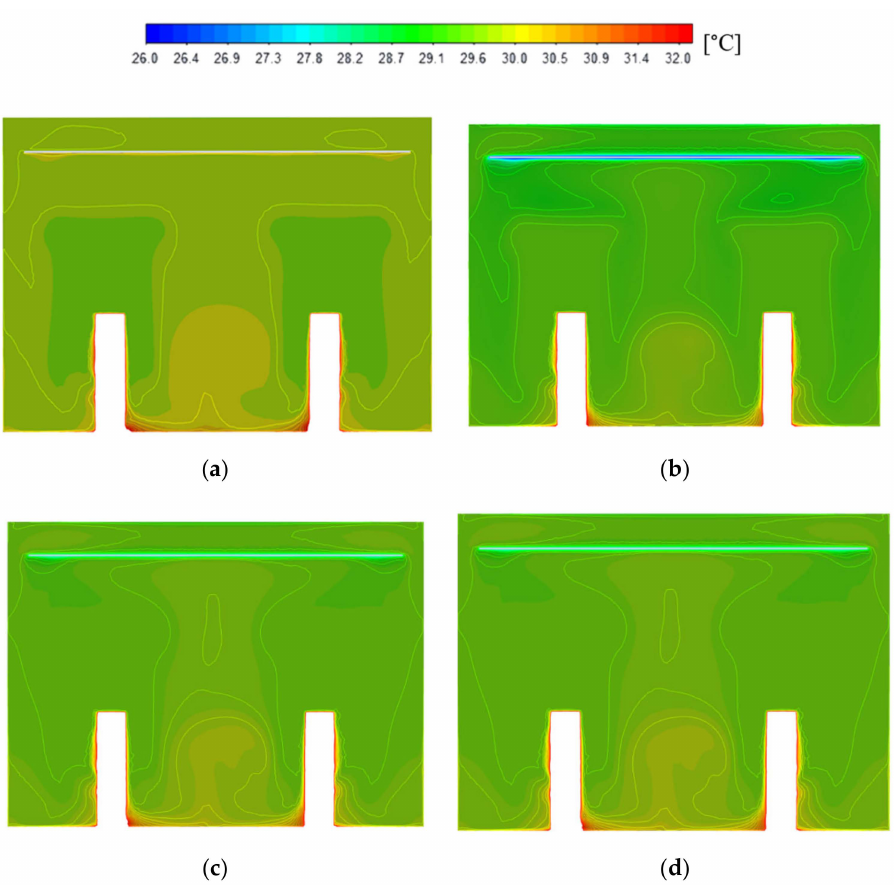
Figure 3. Temperature contours (1.6 m from the wall) for the four different scenarios: ( a ) natural ventilation with radiant cooling, ( b ) hybrid system with CCP surface temperature of 26 ◦ C, ( c ) hybrid system with CCP surface temperature of 27 ◦ C, and ( d ) hybrid system with CCP surface temperature of 28 ◦